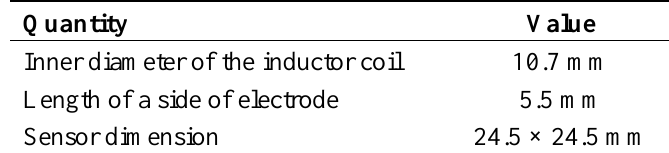
Table 5. The geometrical parameters of the sensor design after fabrication